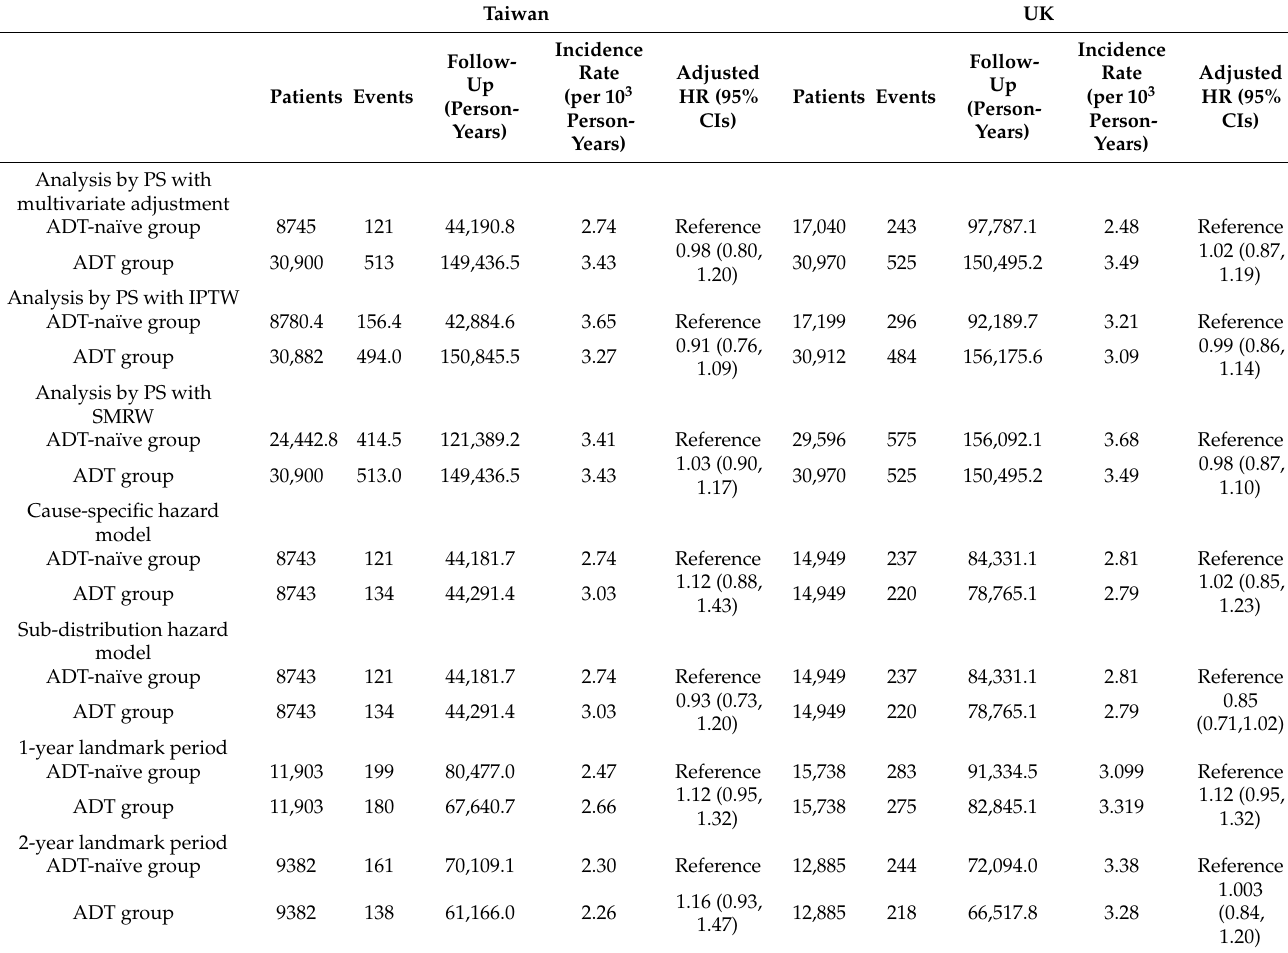
Table 3. Sensitivity